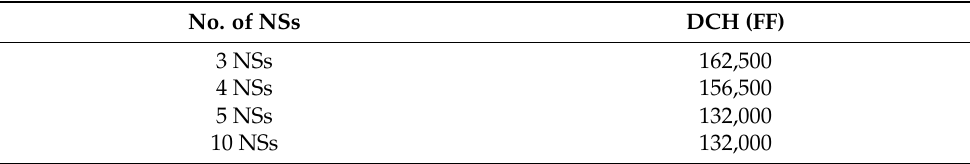
Table 6. The best individual found in case 2 for the dataset [37].